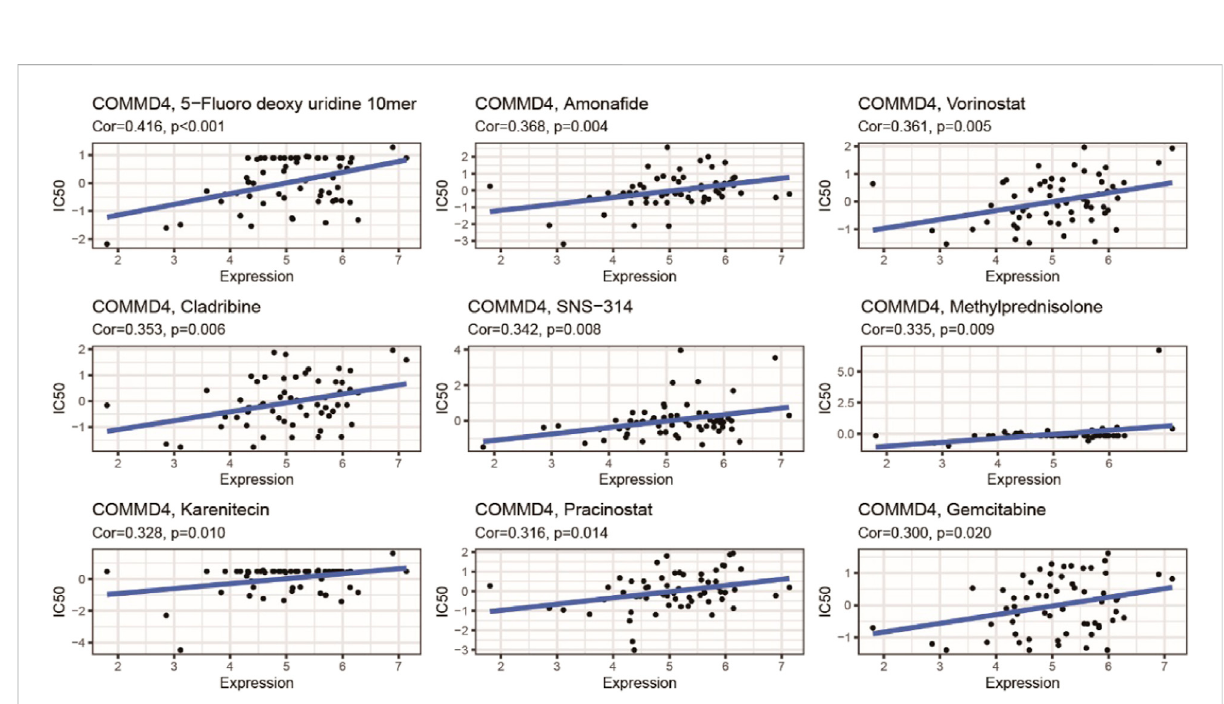
FIGURE 9 An illustration of the relationship between COMMD4 expression and expected medication response.